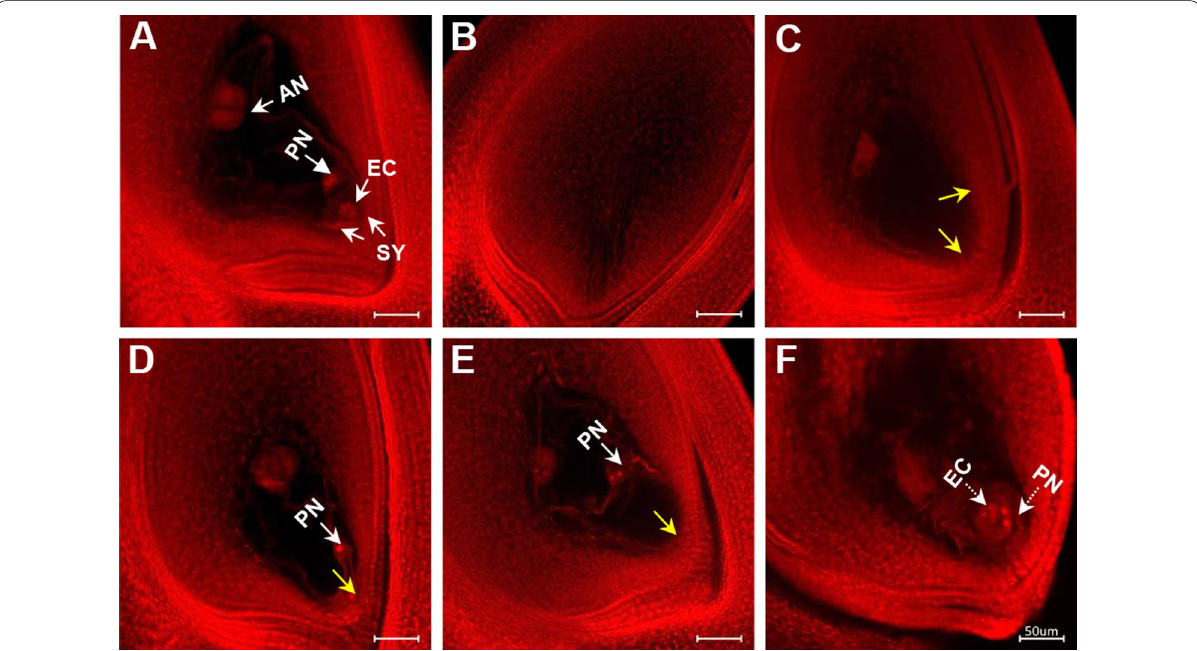
Fig. 4 Mature embryo sac at heading stage (post‑stress recovery) in IR64 plants exposed to six days of control (30 °C, panel A ) and heat stress (38 °C—HT38; 40 °C—HT40, panels B to F ) during gametogenesis. ( A ) A normal mature embryo sac with antipodal cells (AN), two polar nuclei (PN), two synergid cells (SY) and one egg cell (EC) under control (30 ℃ ); ( B ) Degenerated embryo sac, without differentiation of embryo sac cavity; ( C ) Abnormal embryo sac without female germ unit, including egg cell and polar nuclei (indicated by yellow arrows); ( D ) Abnormal embryo sac without egg cell (yellow arrow); ( E ) Abnormal embryo sac without egg cell (yellow arrow) and two polar nuclei located far from female units (white arrow); and ( F ) Egg cell and polar nuclei were at the wrong position (two polar nuclei were closer to micropylar region than the egg